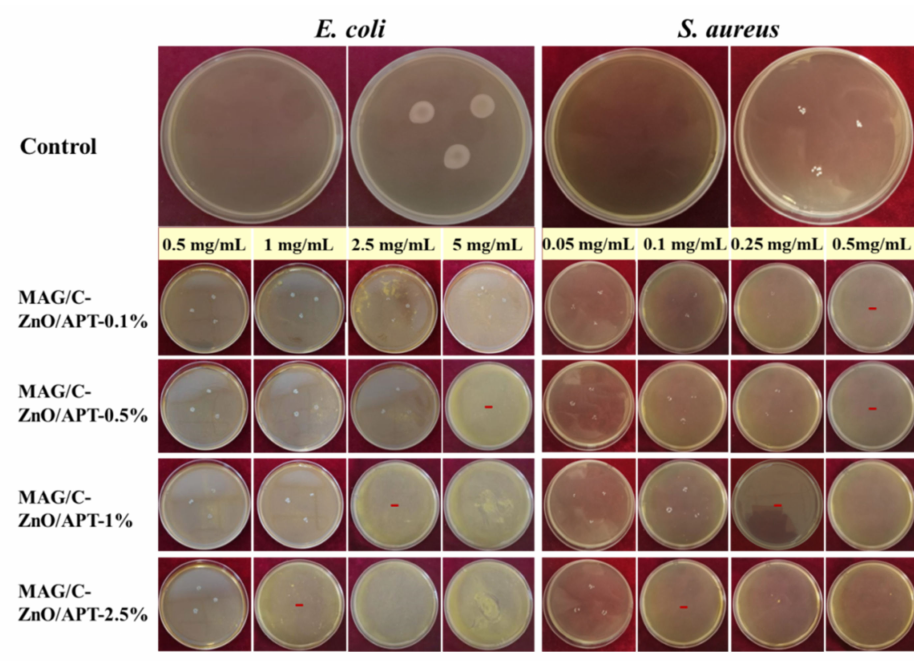
Figure 5. MIC values of MAG/C–ZnO/APT nanocomposites toward E. coli and S. aureus . The red “-” denotes no bacteria in the